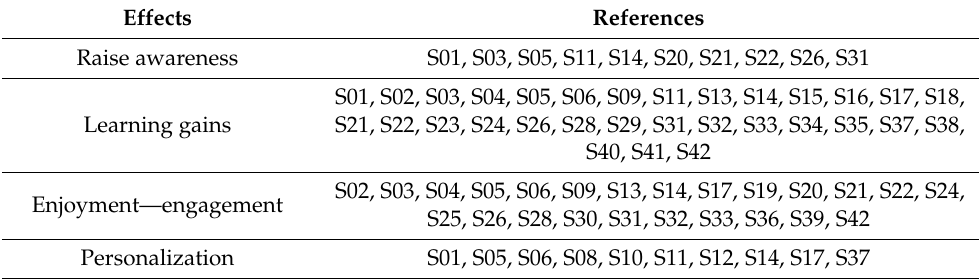
Table 7. Learning effects (selected